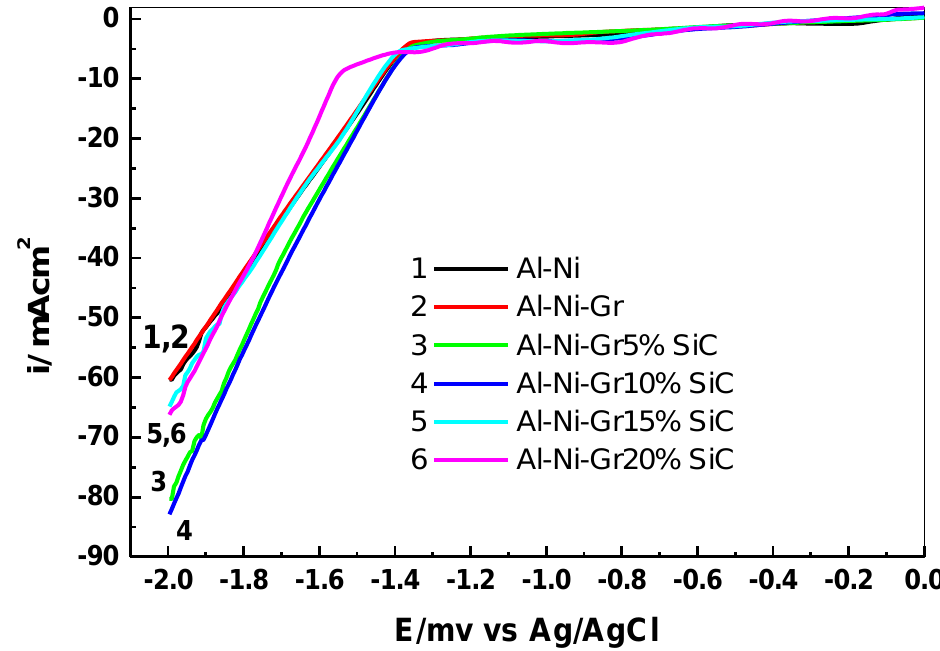
Figure 9. Current – potential curves recorded with various Al-Ni-Gr-SiC substrates. Figure 9. Current–potential curves recorded with various Al-Ni-Gr-SiC